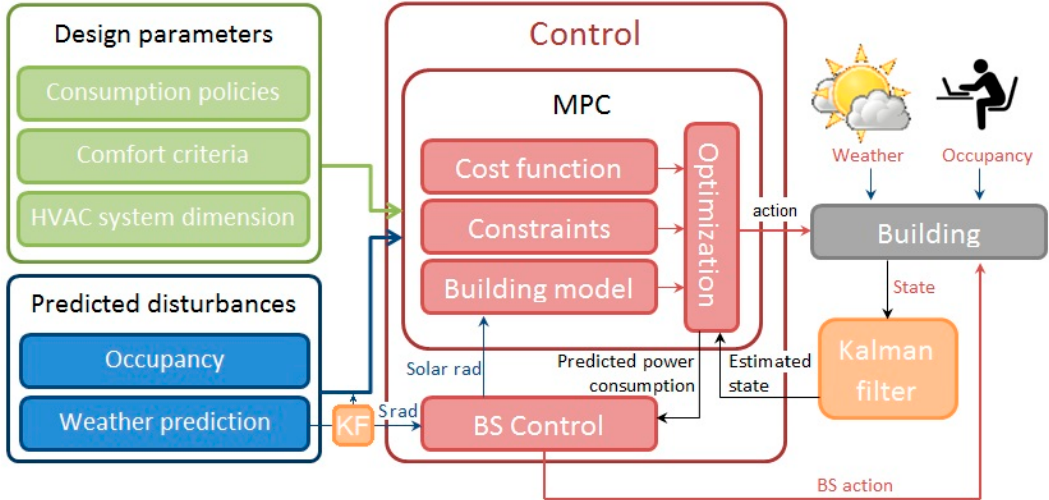
Figure 3. Model Predictive Control (MPC) scheme of the control for the the Heating, Ventilating and Air-Conditioning (HVAC) system of a building with the proposed enhanced Blind System Control (BSC).